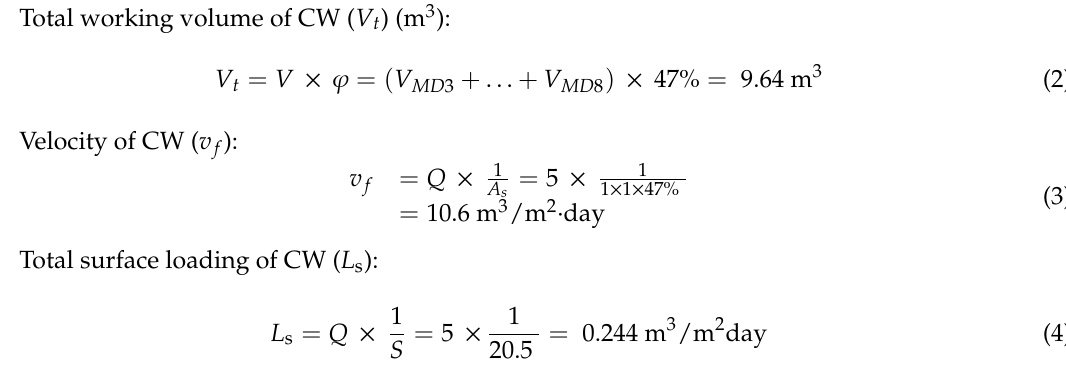
tank, MD3–MD8: constructed wetlands modules.